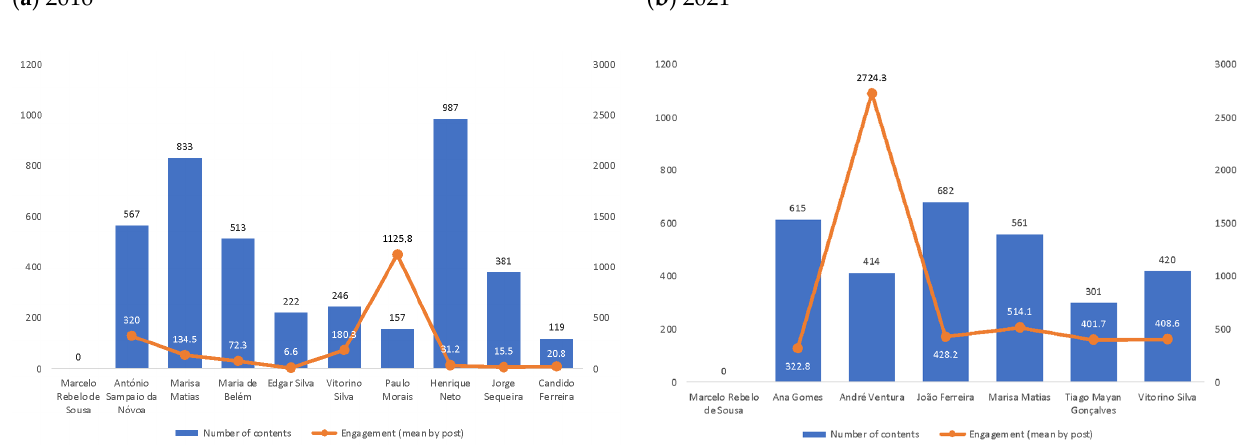
Figure 4. Online campaigning in 2016 and 2021: Activity and Impact. ( a ) 2016 election; ( b ) 2021 election. Source: Own data (see Section 3.1.2).